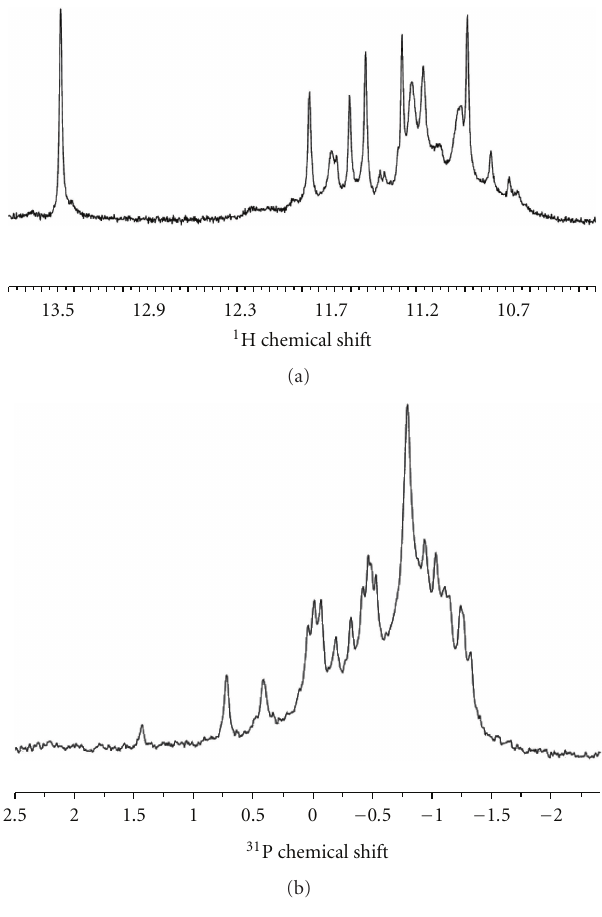
Figure 3: NMR analysis of Gq23 structure. (a) The imino proton region of 1D 1 H NMR spectrum of Gq23. (b) 1D proton-decoupled 31 P NMR spectrum of